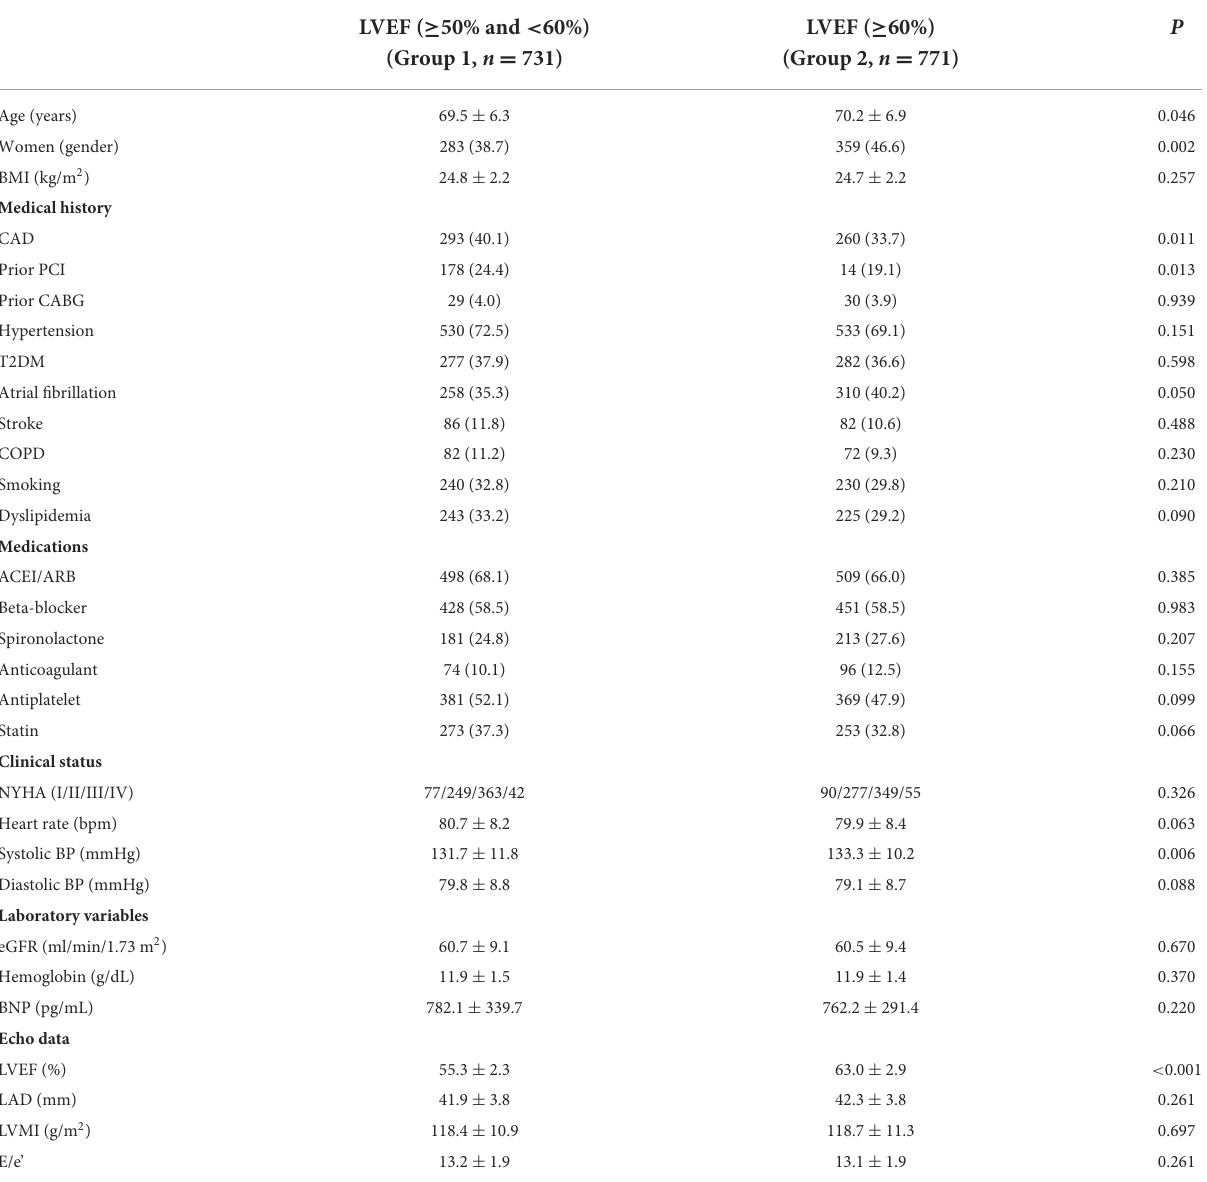
TABLE 1 Baseline